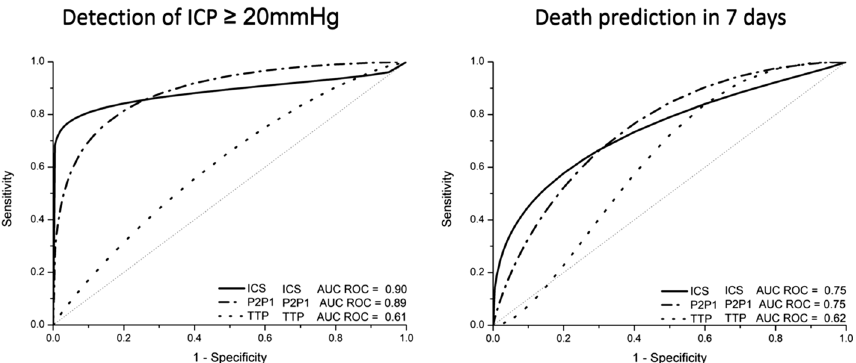
Fig. 1 Area under receiver operator curve (AUROC) analysis of P2/P1 ratio, TTP and ICS to intracranial hypertension detection (left) and death prediction (right). ICP: intracranial pressure, ICS: Intracranial Compliance Scale, TTP: time-to peak. AUROC analysis—J Hopkins Web Tool (Johns Hopkins University. Available from: http:// www. jrocfi t.